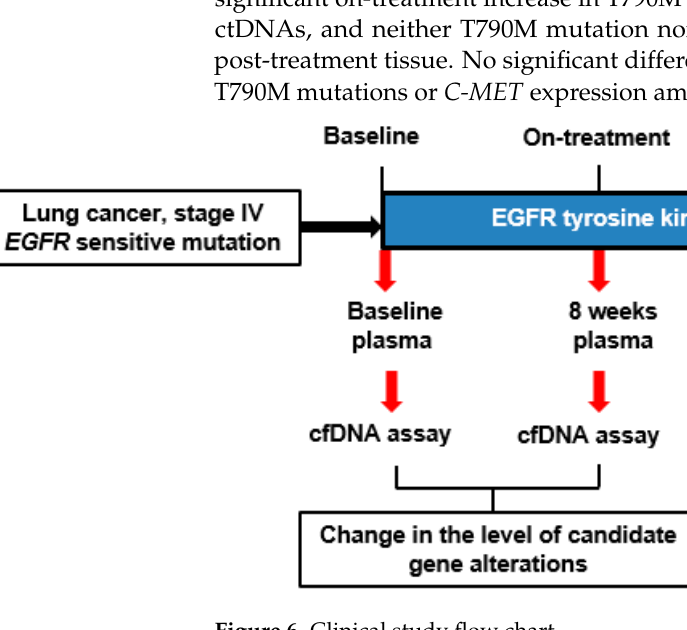
Figure 6. Clinical study flow chart. Table 1. The association between the on-treatment plasma cell-free DNA level of gene alterations and final resistance mechanism for EGFR-targeted inhibitors.